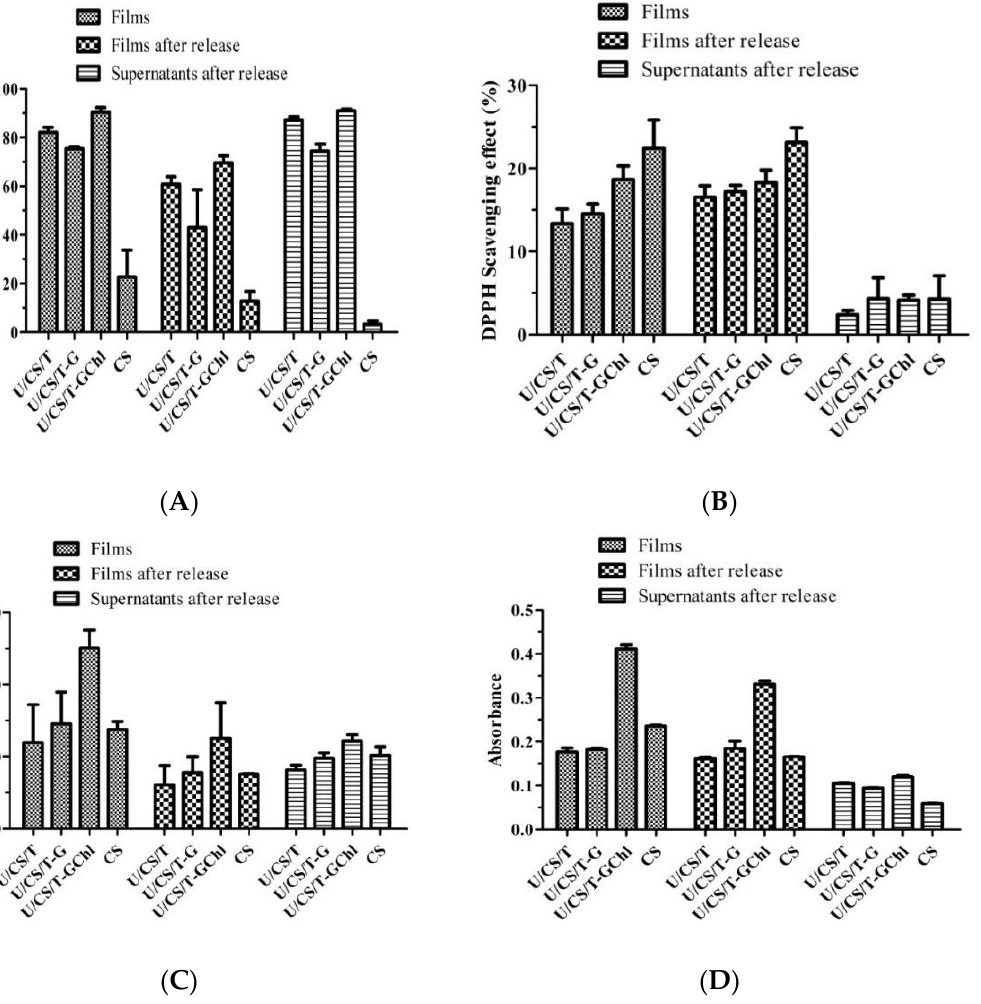
Figure 3. Antioxidant activities of the ulvan/chitosan complex films before and after ulvan release, and their corresponding supernatants after release ( A ) DPPH radical scavenging activity, ( B ) ferrous iron chelating ability, ( C ) superoxide anions scavenging activity, and ( D ) reducing power activity. All the complex films had the same composition of U/CS/T at 20/75/5. Data were represented by the mean ± SD, n = 3.